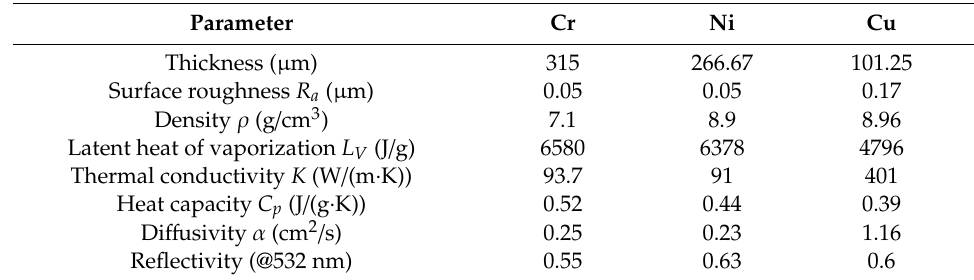
Table 1. Parameters of untreated metal sheets used in experiments [46]. The reflectivity was calculated from the optical constants of the metals according to